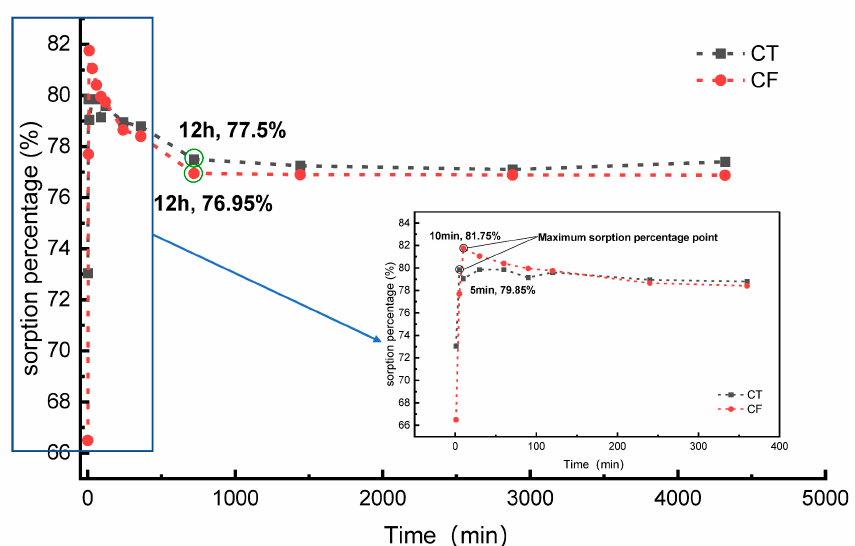
Figure 3. Sorption percentage for the sorption of Sr by CT and CF. C [Sr]initial = 20 mg/L, colloid amount = 35.7 mL, solid content = 2.5 g, pH = 7.0.